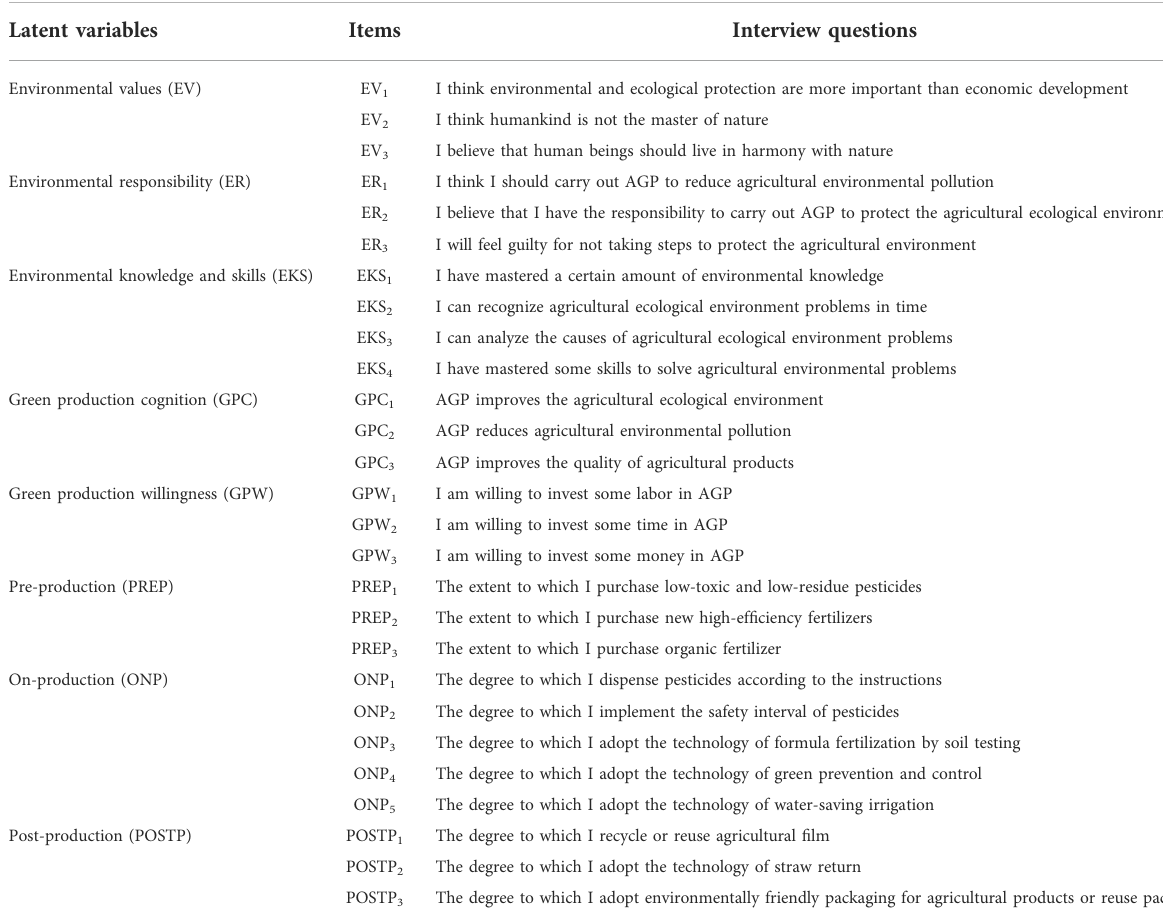
TABLE 2 Measurement items of the latent